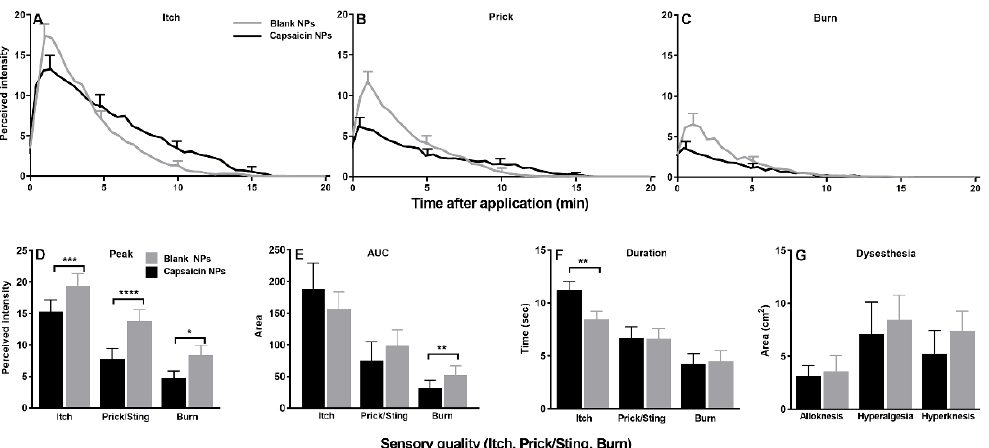
Figure 8. Effects of capsaicin NP pretreatment on sensations and dysesthesias evoked by injection of BAM8-22. ( A – C ) Time course of perceived intensities of itch, pricking/stinging, and burning. Same format as Figure 7. ( D ) Peak magnitude (Peak) of each sensory quality. ( E ) Area under the rating curve (AUC). ( F ) Duration of response. ( G ) Area of each type of dysesthesia: alloknesis, hyperalgesia and hyperknesis. n = 21, ( A – C ) repeated measures two-way ANOVA; two repeated treatment groups (capsaicin vs. placebo treatment) × 40 repeated timepoints (0–20 min) with Bonferroni correction, ( D – G ) Wilcoxon test. Data are means with SEMs. * p < 0.05, ** p < 0.01, *** p < 0.001 and **** p < 0.0001